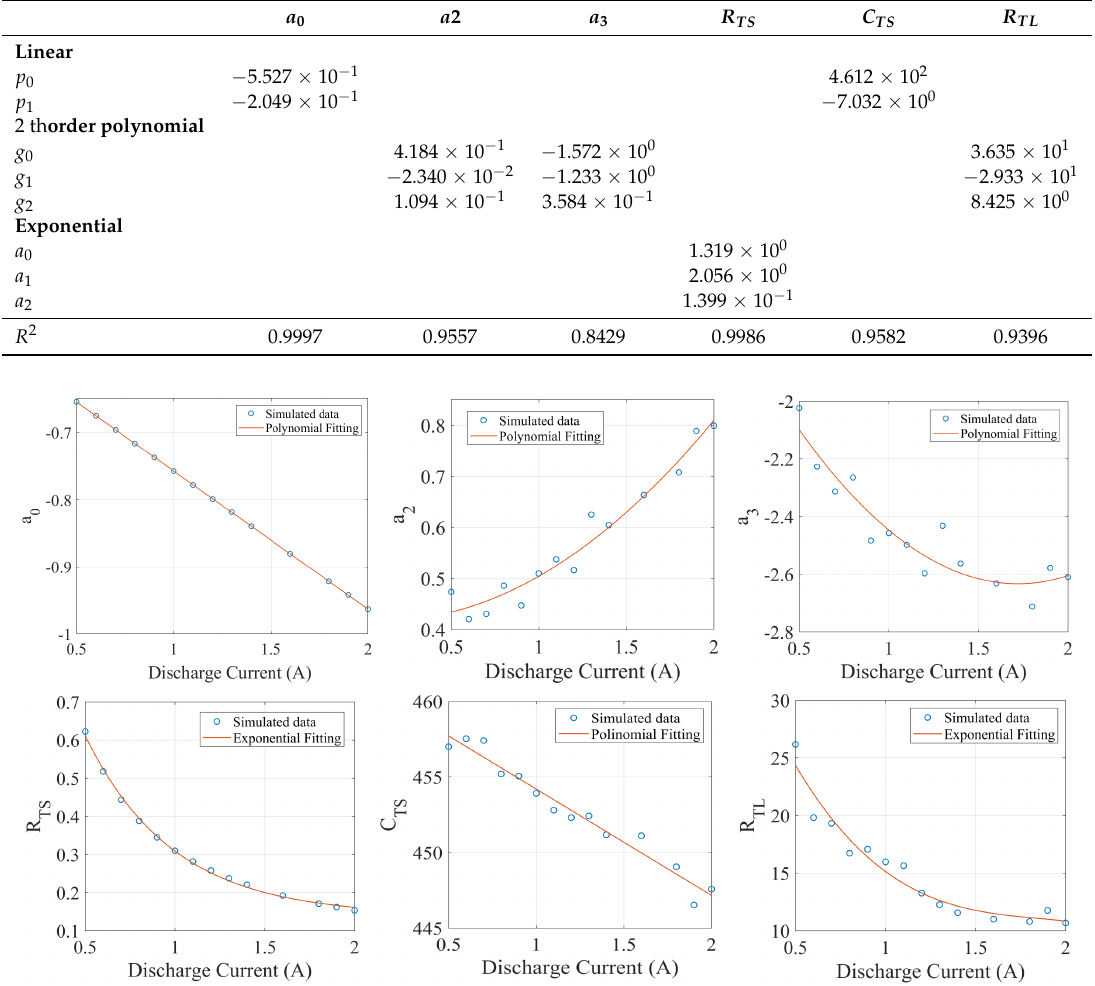
Figure 3. Parameters’ trends for a Li-ion, C = 2.6 Ah battery: a 0 , a 2 , a 3 , C TS and R TL are represented by a polynomial function: f ( x ) = p 0 + p 1 x , g ( x ) = g 0 + g 1 x + g 2 x 2 ; meanwhile, R TS is fitted by means of an exponential function: h ( x ) = a 0 e − a 1 x + a 2